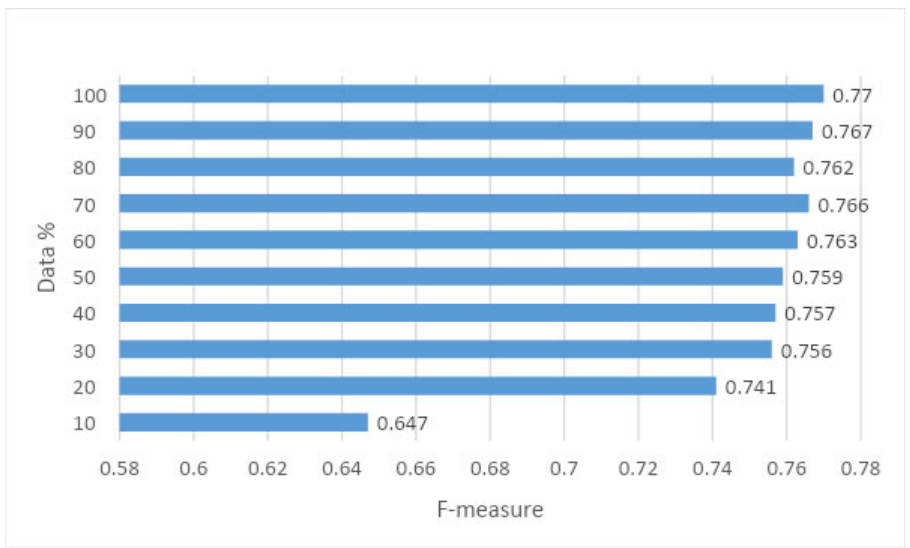
Figure 6. F ‐ measure for Bayesian Network with a random subset. Figure 6. F-measure for Bayesian Network with a random subset.